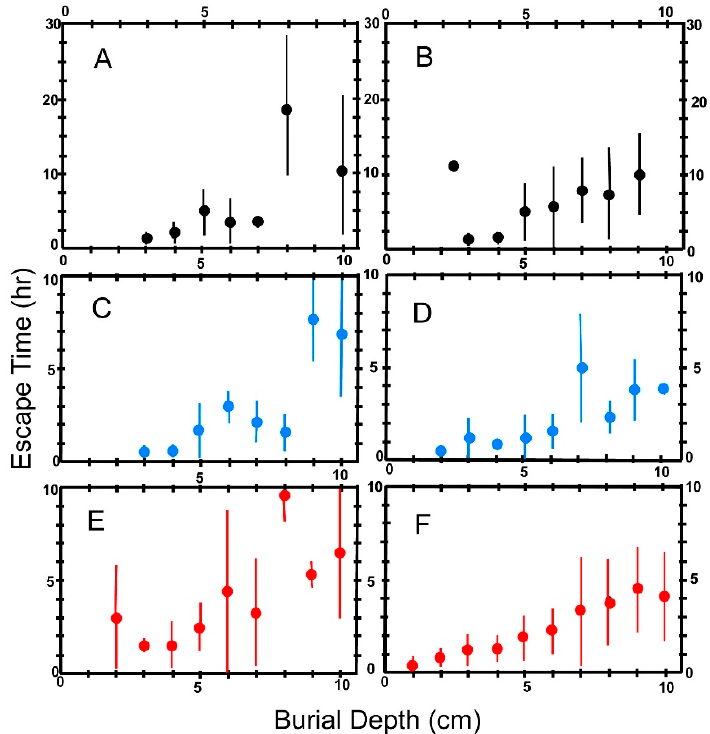
Figure 13. Escape times for the three test species plotted as a function of burial depth. Escape time is the time required for an animal to reach the new sediment-water interface after anastrophic burial. Burial depth defined as in Figure 10. Each point plotted on the graphs represents the mean of escape times for animals buried at the indicated depth. The vertical bars give ±1 σ . ( A , B ) Pyganodon cataracta ; ( C , D ) Elliptio complanata ; ( E , F ) Corbicula fluminea ; ( A , C , E ): Burial in coarse sand (0 Φ ≥ grain size ≥ 1 Φ ). ( B , D , F ): Burial in fine sand (2 Φ ≥ grain size ≥ 3 Φ ).